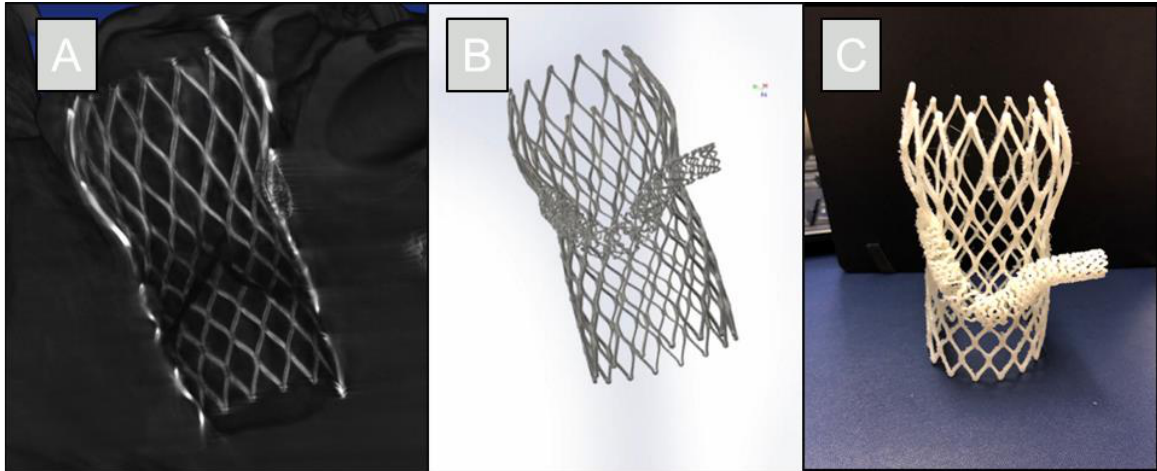
Figure 4. The reconstruction was made from a micro-CT scan with ~55-micron resolution ( A ). The reconstruction was segmented and converted into a computational model of the chimney technique ( B ). This model can then be used as an educational tool, including 3D printing of the resultant pro- cedure ( C